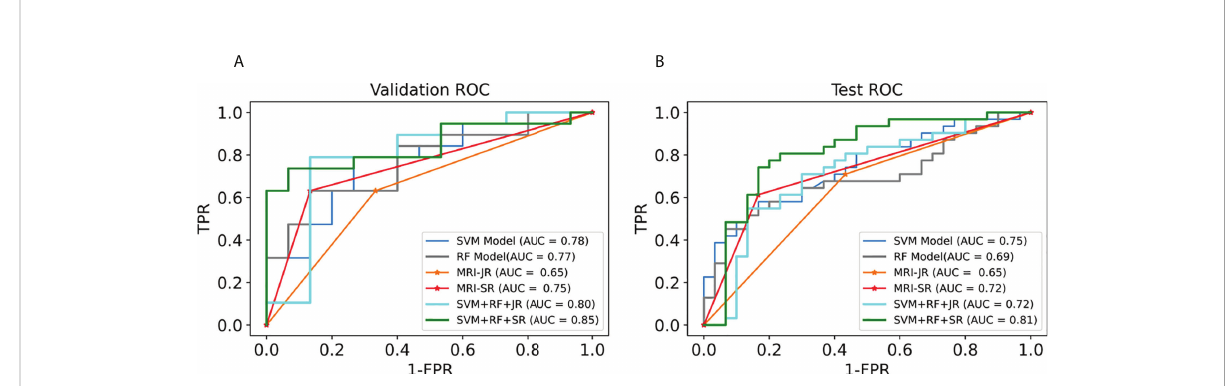
FIGURE 5 Comparison of ROC between the ML models and MRI in the validation set and test set. (A) shows the ROC curves of the validation set. (B) shows the ROC curves of the test set. (MRI-JR: junior radiologists ’ diagnosis based on MRI, MRI-SR: senior radiologists ’ diagnosis based on